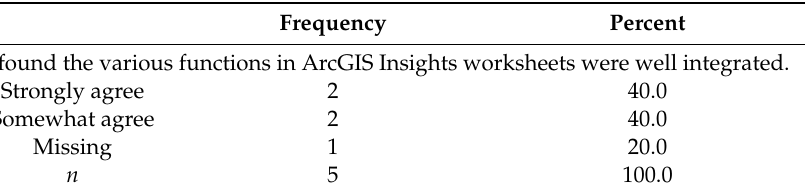
Table 7. Percentages and Frequencies, Q50.